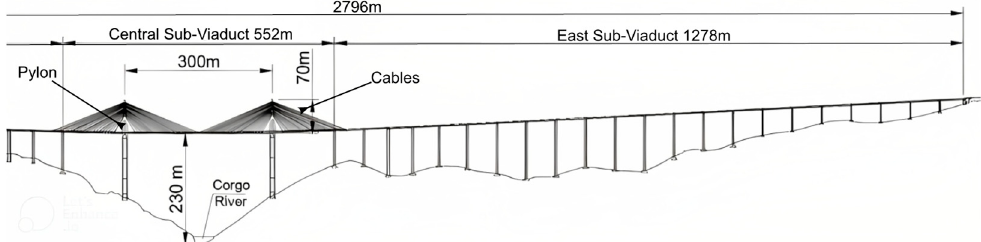
Figure 11. Schematic view of the Corgo Bridge [96].